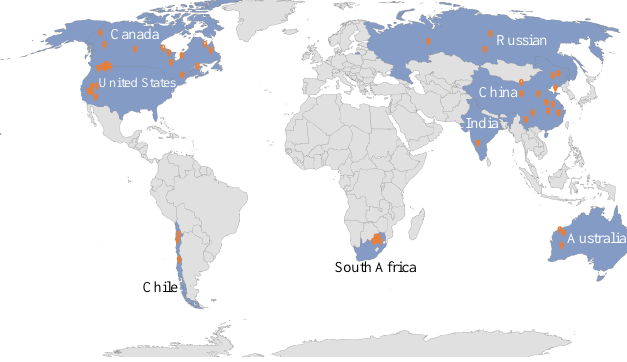
Figure 1. Distribution of typical mines prone to rockburst in the world.